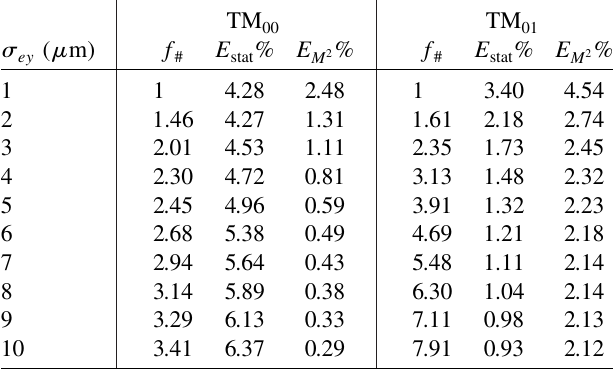
TABLE IV. Optimal f -numbers (for E ) and corresponding stat statistical precision for electron bunches with aspect ratio (cid:1) 10 , (cid:13) (cid:1) 532 nm . The laser M 2 (cid:1) 1 : 3 for both =(cid:2) (cid:2) ex ey and TM modes. The minimum practical f -number is TM 00 01 taken as 1.0, even where a better statistical precision could in principle be obtained by smaller f -numbers. The factor of 1.15 calculations. Also shown is of Eq. (A11) is included in the TM 01 if there is a 5% error in the value of the laser M 2 . the error E M 2